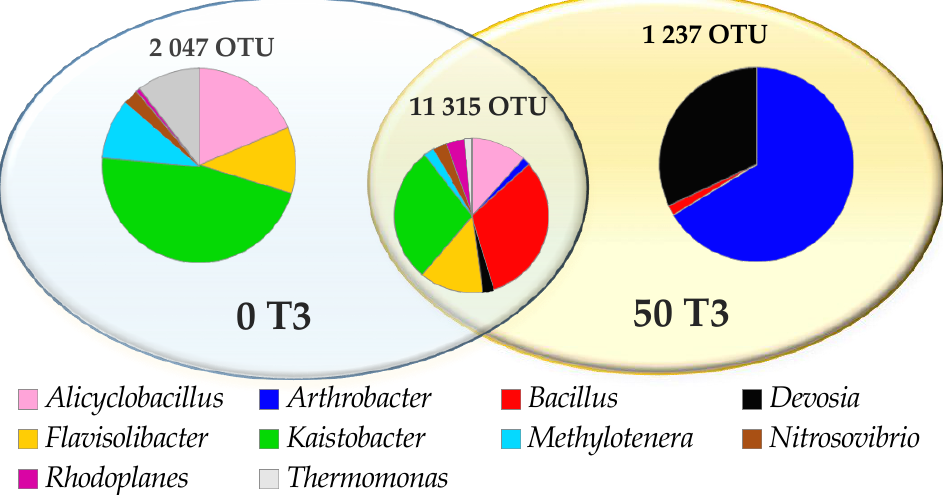
Figure 11. Read of the common operational taxonomic units (OTU) of bacteria ≥1% genus level in the control soil (0 T3) and in soil contaminated with 50 mg o -cresol (50 T3) on day 45 of the experi- ment.